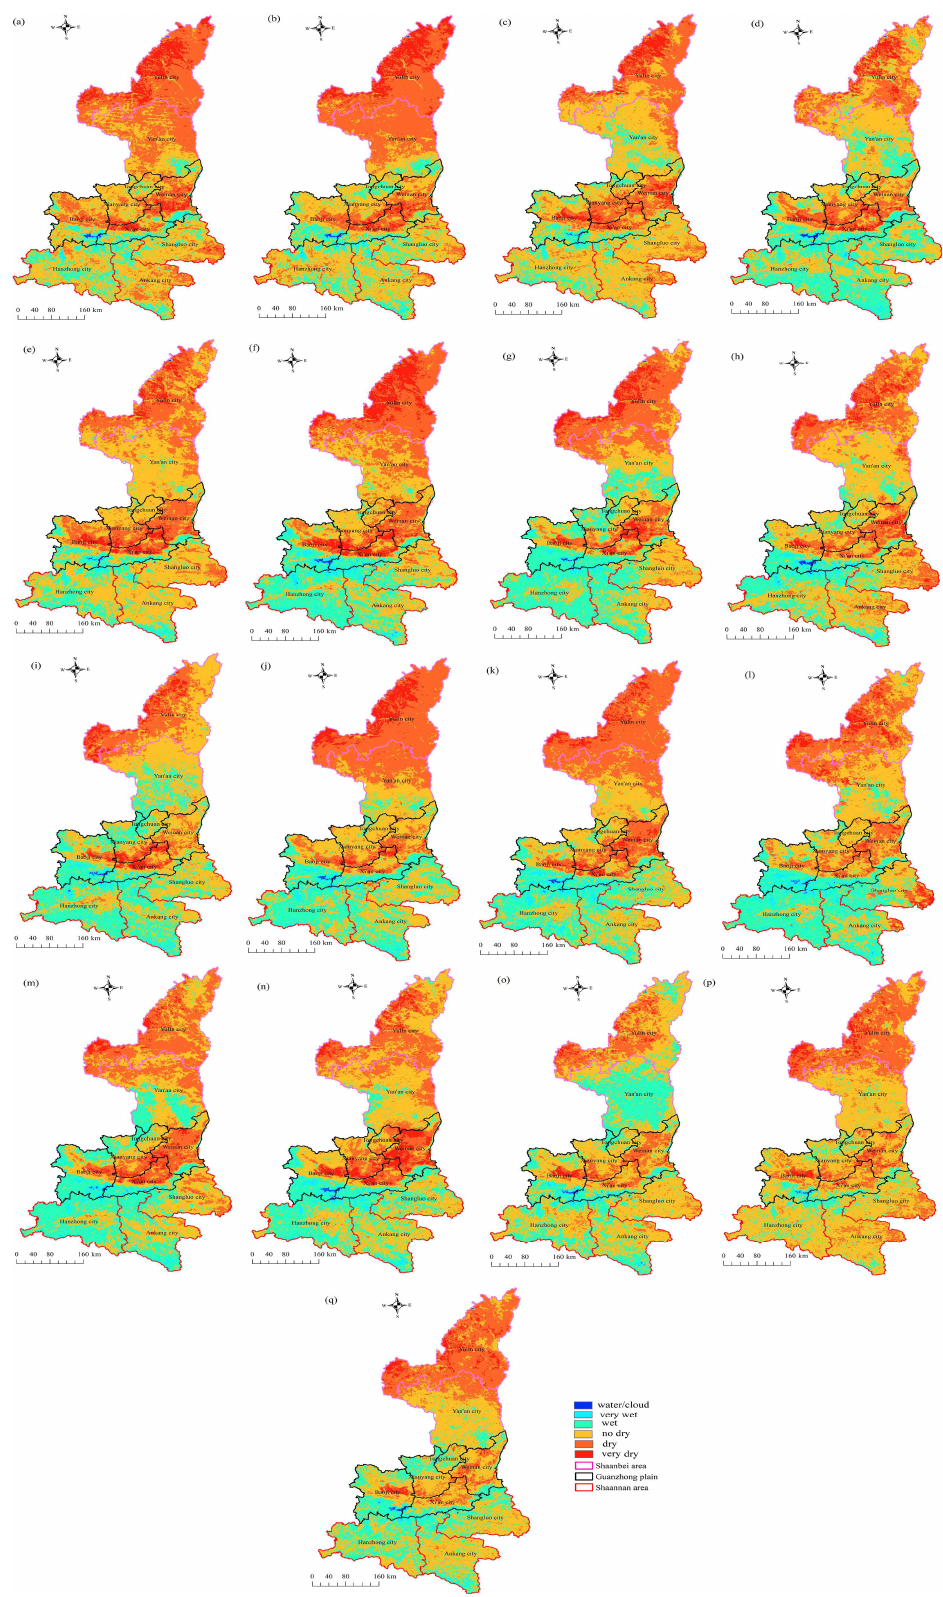
Figure 5. Spatiotemporal variation of drought in Shaanxi province between 2000 to 2016. ( a ) 2000, ( b ) 2001, ( c ) 2002, ( d ) 2003, ( e ) 2004, ( f ) 2005, ( g ) 2006, ( h ) 2007, ( i ) 2008, ( j ) 2009, ( k ) 2010, ( l ) 2011, ( m ) 2012, ( n ) 2013, ( o ) 2014, ( p ) 2015, ( q ) 2016.